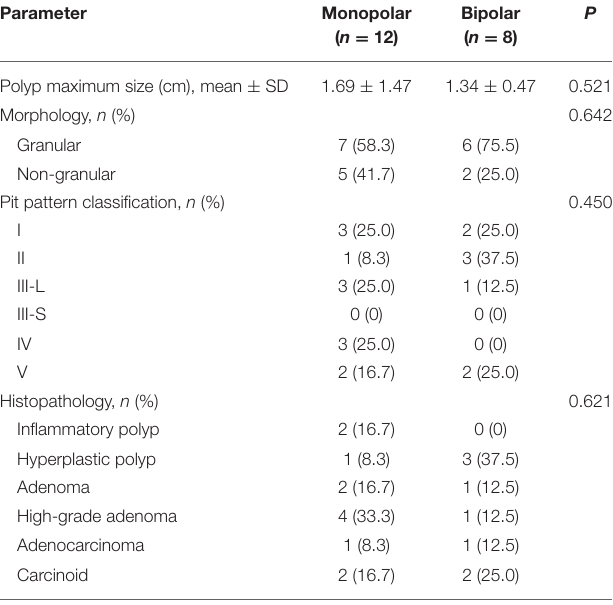
TABLE 3 | Characteristics of esophageal lesions in patients who underwent esophageal ESD. Parameter Monopolar